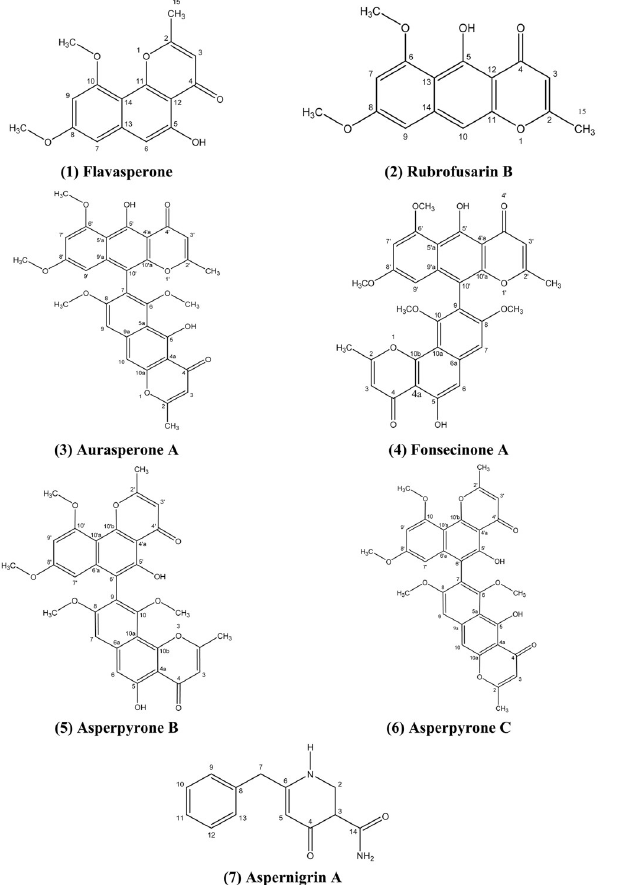
Fig 1. Structures of compounds isolated from Aspergillus niger